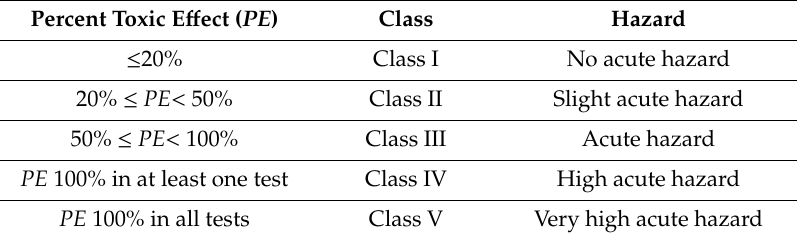
Table 1. Hazard classification system for